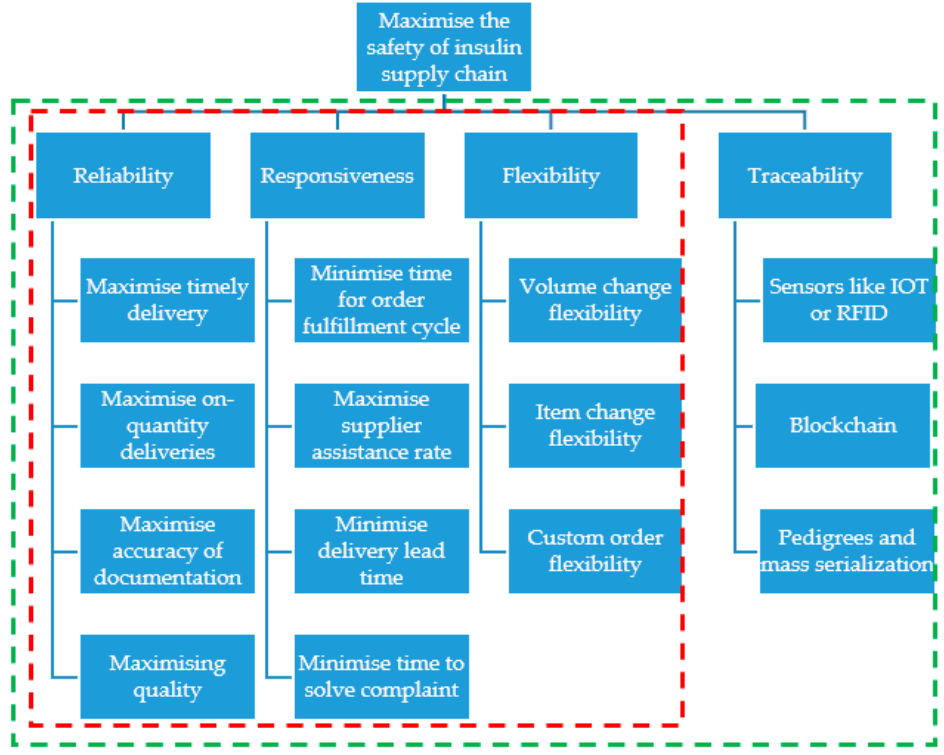
Figure 5. Scenarios 1 and 2 for the insulin supply chain.